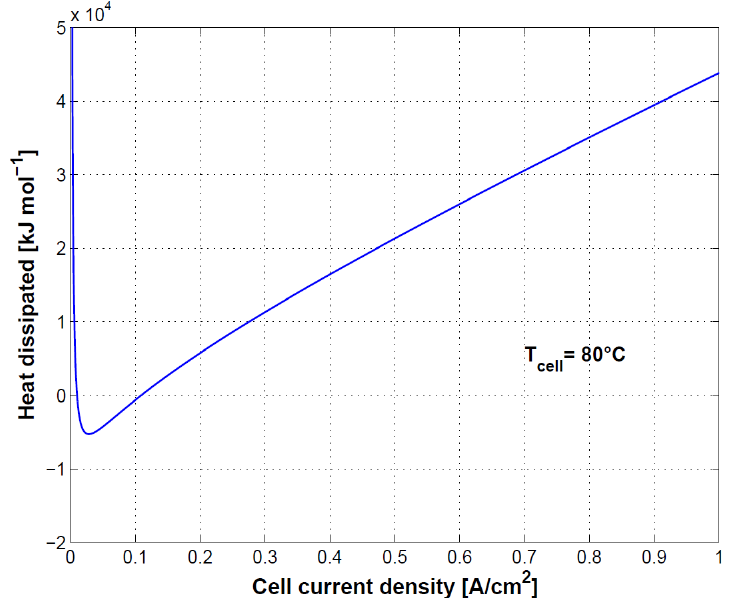
Figure 12. Predicted cell heat loss at temperature of 80 °C.